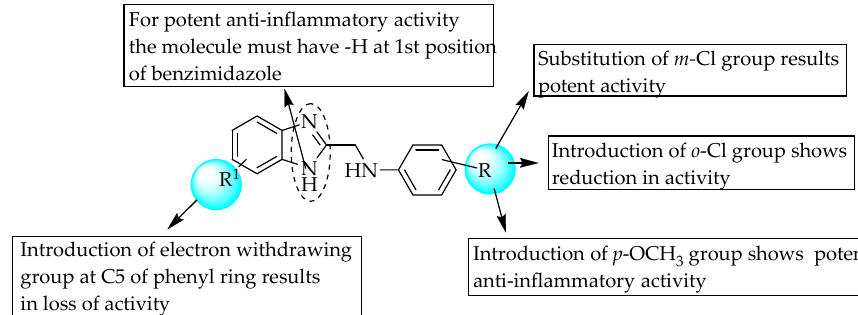
Figure 40. SARs of substituted anilines at C2 position of 6-substituted benzimidazoles .